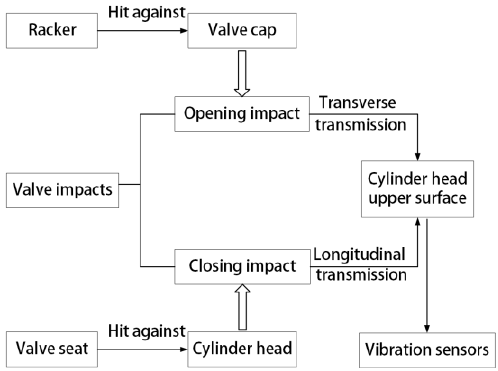
Figure 4. Valve impacts transmission paths.